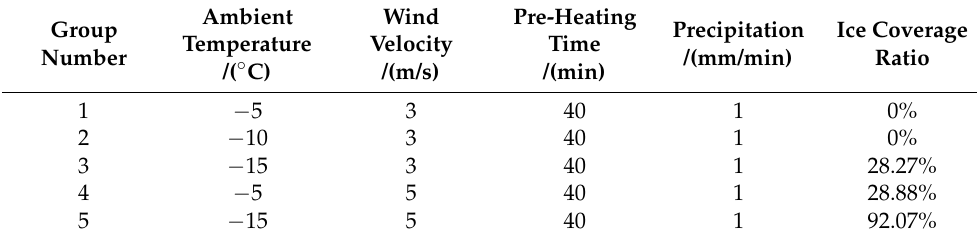
Table 4. The test conditions and the ice coverage ratio of icing tests under windy